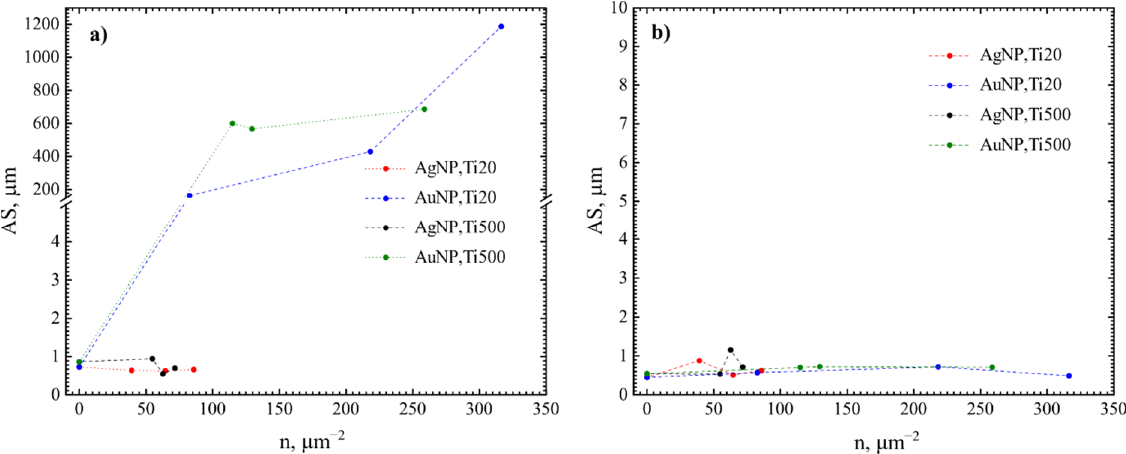
Figure 13. Average size of bacteria colonies: ( a ) N. sicca and ( b ) V. parvula.